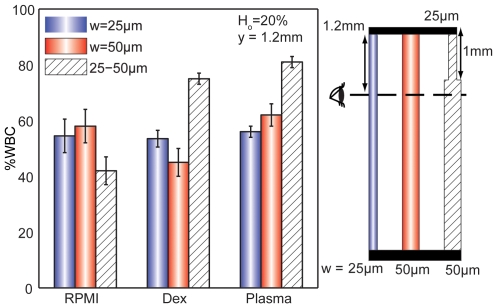
WBC margination varies with blood hematocrit.In plasma, when y = 4.95 mm and Ho = 20%, straight channels exhibit maximum WBC margination. Lower (Ho = 10%) and higher (Ho = 40%) results in poor margination